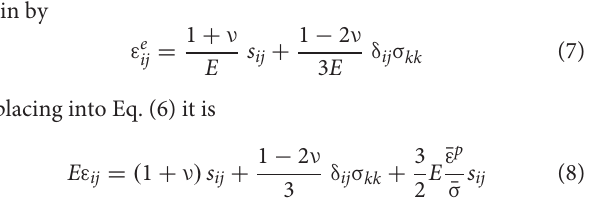
FIGURE 3 | Torsional buckling of cruciform column under axial